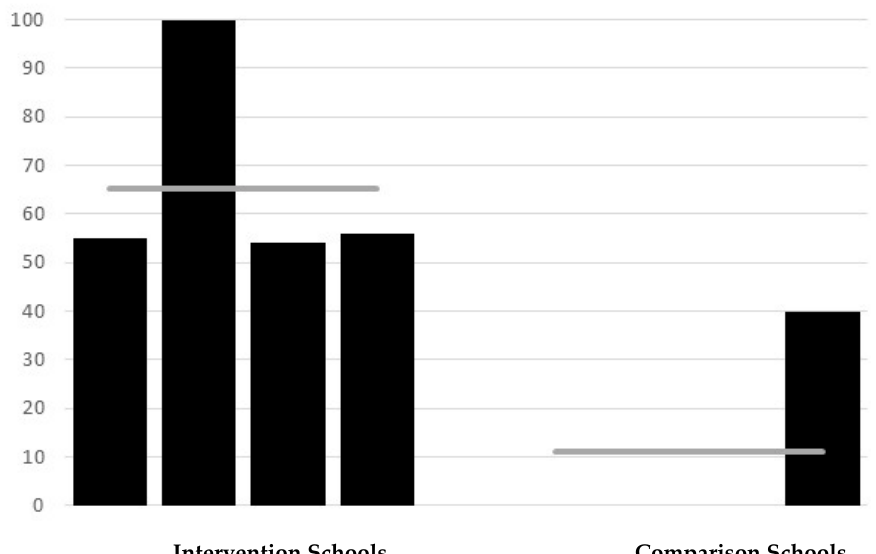
Figure 2. Direct observation of handwashing: percentage of children who washed hands with soap after going to the toilet in intervention and comparison schools. Horizontal line represents the average for schools.